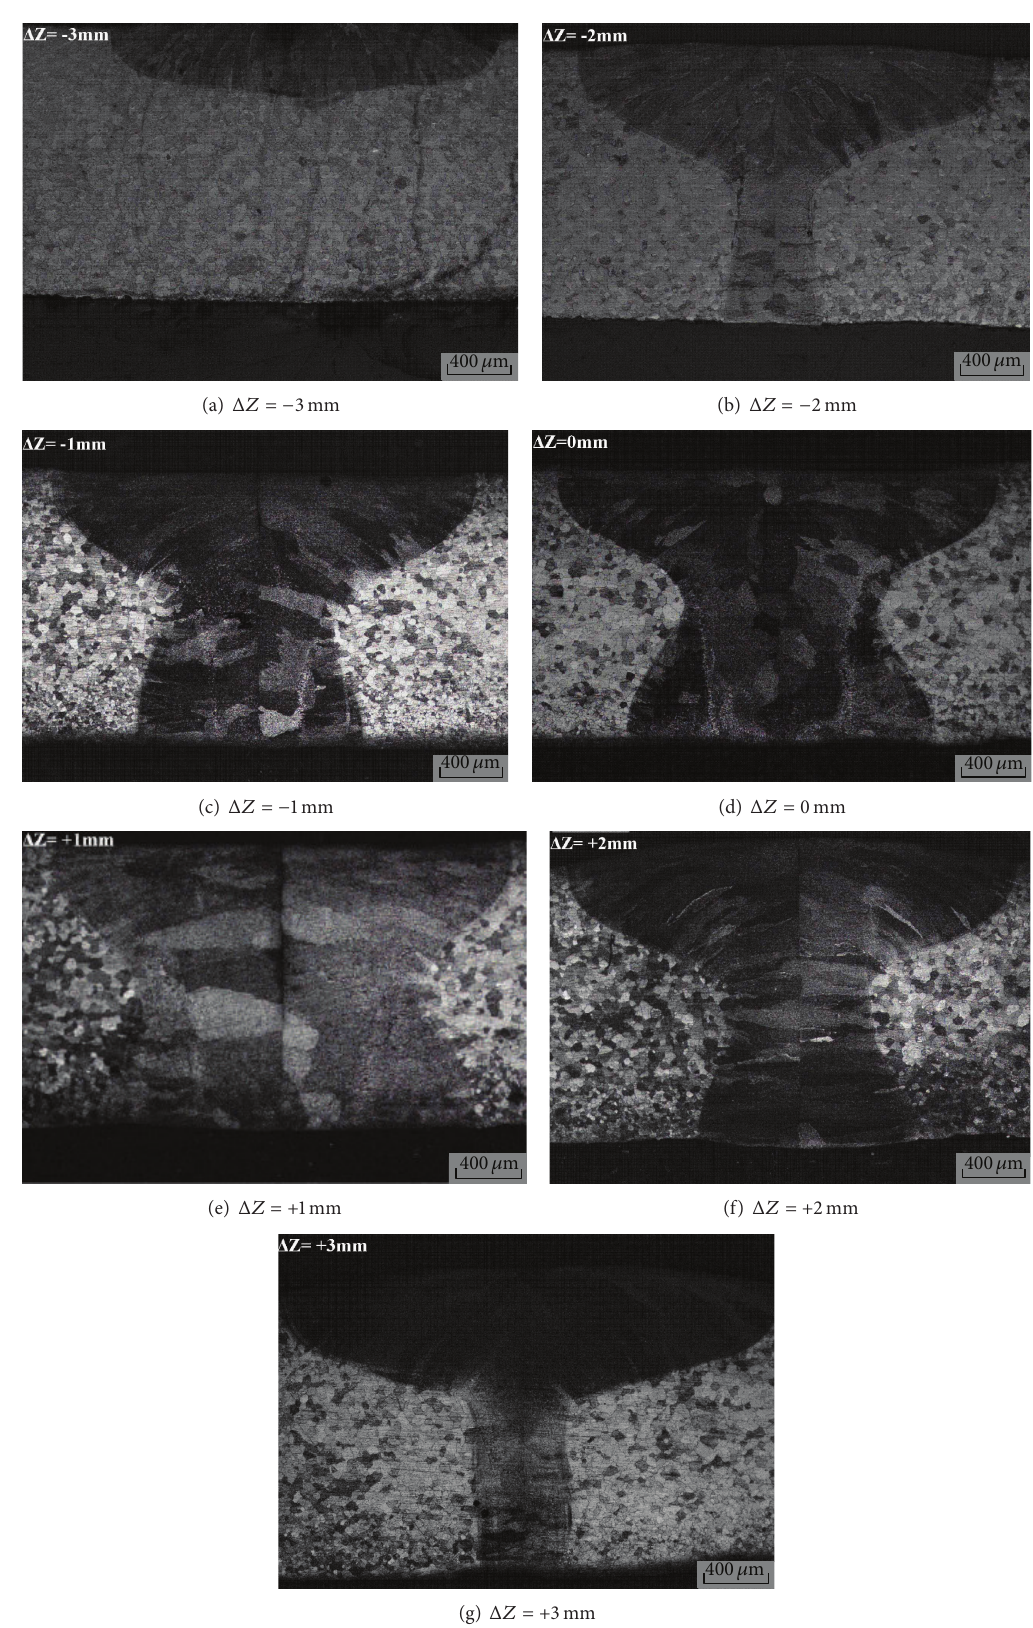
Figure 5: Influence of defocus amount on cross-section morphologies of welded seam. ( 𝑃 = 1610 W; 𝑉 = 1.5 m/min; 𝑈 𝑓 = 15